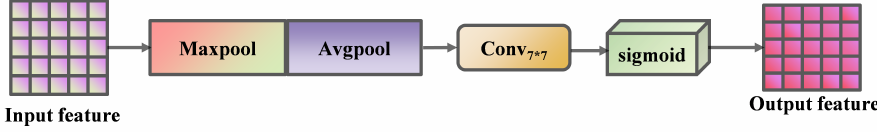
Figure 4. Structure of spatial attention